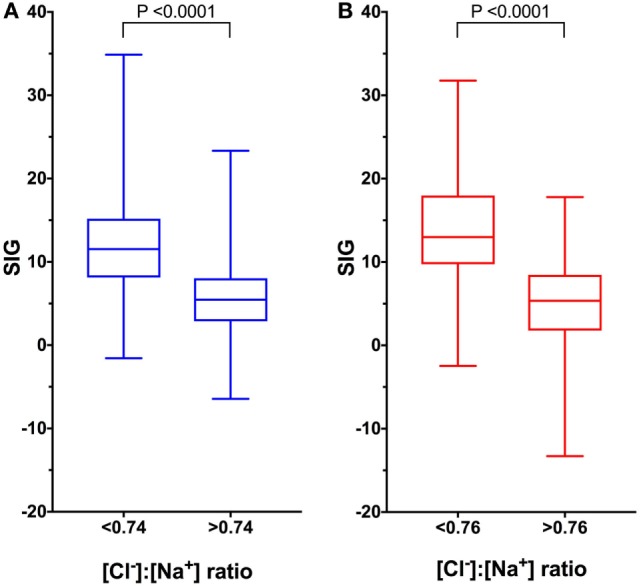
Box and whisker plots of canine (blue) and feline (red) comparing strong ion gap (SIG) values in patients with low and normal or high [Cl−]:[Na+] ratio values. Boxes represent the 25th and 75th percentiles, the middle line represents the median and the whiskers represent minimum and maximum values. (A) In dogs, SIG is significantly greater in animals with metabolic acidosis and hypochloremia as predicted by site-specific reference values for [Cl−]:[Na+] of < 0.74 than in animals with normal or high [Cl−]:[Na+] ratios, P < 0.0001 by Mann–Whitney U test (n = 739). (B) In cats, SIG is significantly greater in animals with metabolic acidosis and hypochloremia as predicted by site-specific reference values for [Cl−]:[Na+] of <0.76 than in animals with normal or high [Cl−]:[Na+] ratios, P < 0.0001 by Mann–Whitney U test (n = 671).